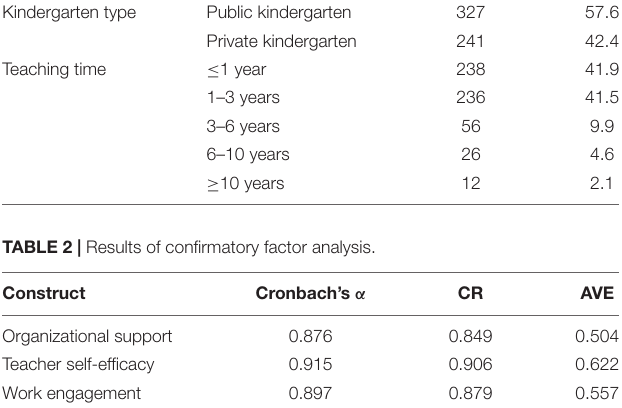
TABLE 4 | Hypotheses